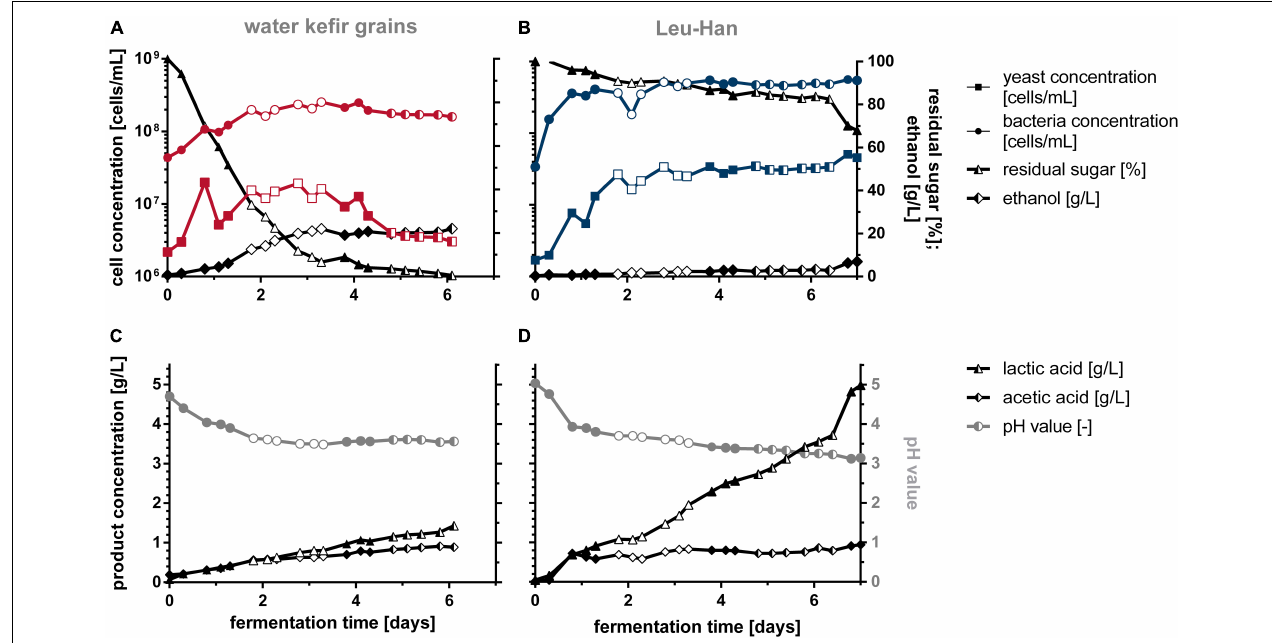
FIGURE 8 | Off-line data of WK fermentations in 5-L bioreactors with grains (A,C) and the defined co-culture Leu + Han (B,D) . Fermentations were conducted in biological triplicates. Data from identical sampling times are shown as the mean value of a triple (full-filled mark), double (half-filled mark), or single (unfilled mark) sampling. WK, water